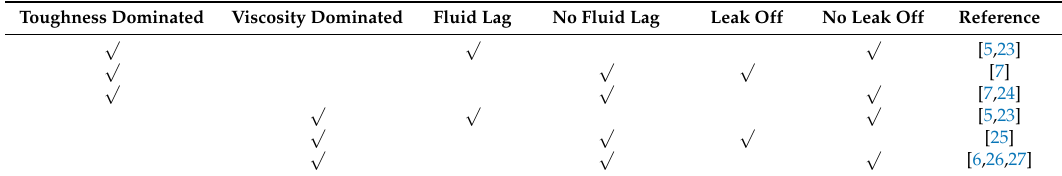
Table 1. Applications of nondimensionalization to deriving analytical or numerical solutions to axial planar HFs.